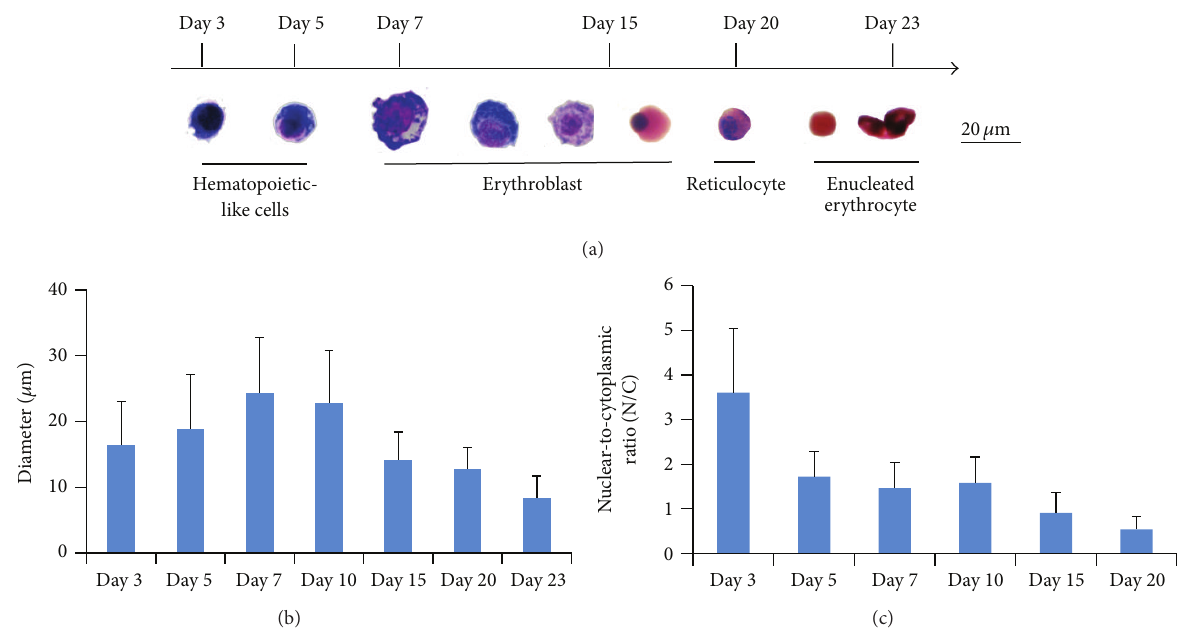
Figure 6: Progressive morphologic changes during generation and maturation of hHFMSC-derived erythroid cells in vitro . (a) Progressive morphologic changes from hematopoietic-like cells, erythroblasts to enucleated erythrocytes, and eventually matured erythrocytes are accompanied by significant increase of hemoglobin and decrease in size during their in vitro differentiation and maturation. Cells were stained with Wright-Giemsa dye. (b) Diameter decreased with time in culture. Data for each day represent diameters of cells. Enucleated cells decreased to less than half the original diameter on day 3 and were 3 times smaller than the macroblast on day 7. (c) Nuclear-to-cytoplasm ratio decreased with time in